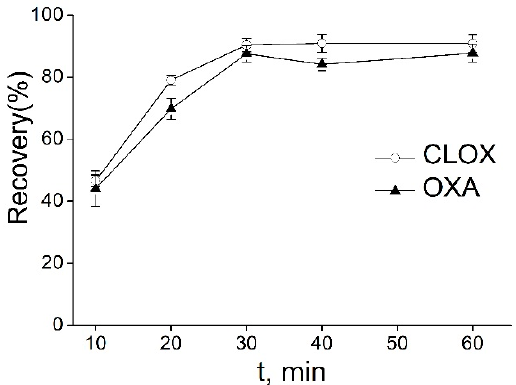
Figure 7. Effect of the extraction time on the recoveries of analytes. Conditions: the amount of PPy-PA6-NFsM, 10.0 mg; sample volume, 20.0 mL; concentration of two analytes, 0.5 µ g / mL; pH, 4.0; eluent, 2.0 mL of 1% ammonia / ACN ( v / v ); desorption time, 30 min.